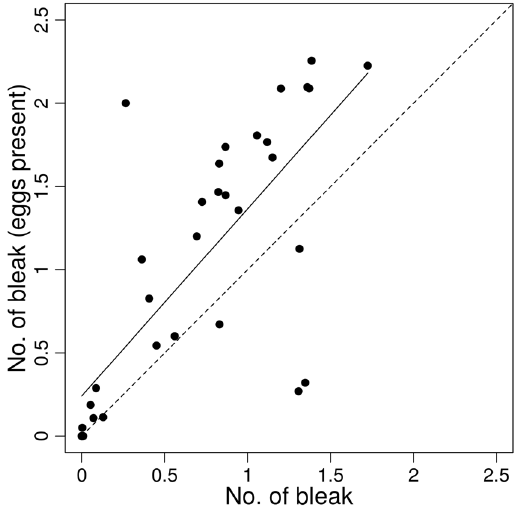
Figure 2. The relationship between the mean number of bleak in camera view during a single video recording and the mean number of bleak in camera view during the same recording when eggs were present in camera view. Dashed line indicates 1:1 ratio, solid line represents trend line and dotted lines represent 95% confidence interval.